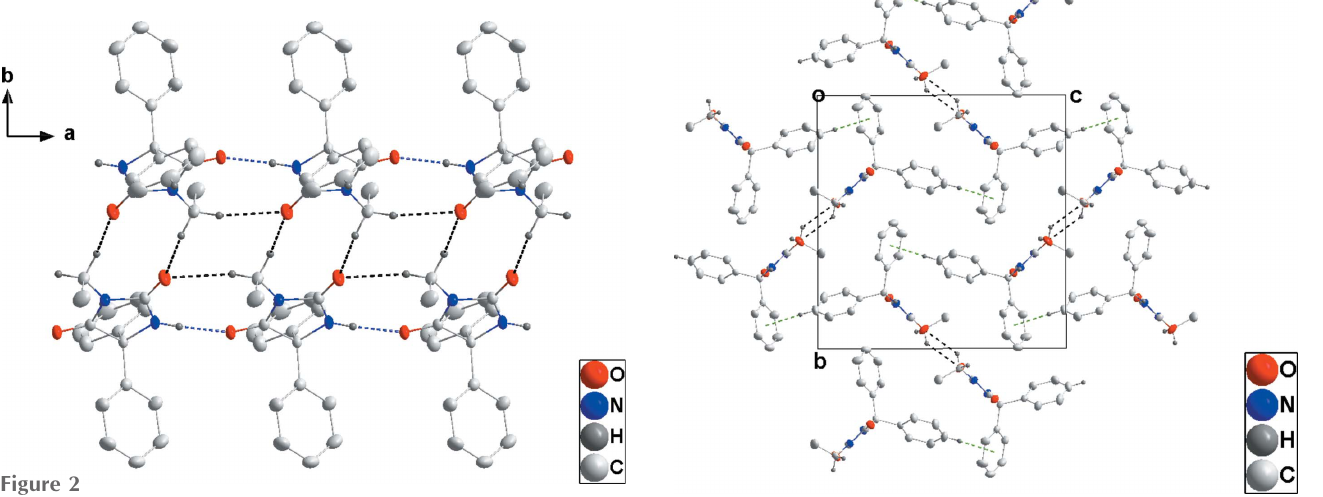
Figure 1 The title molecule showing the labeling scheme and 50% probability displacement ellipsoids for the non-hydrogen